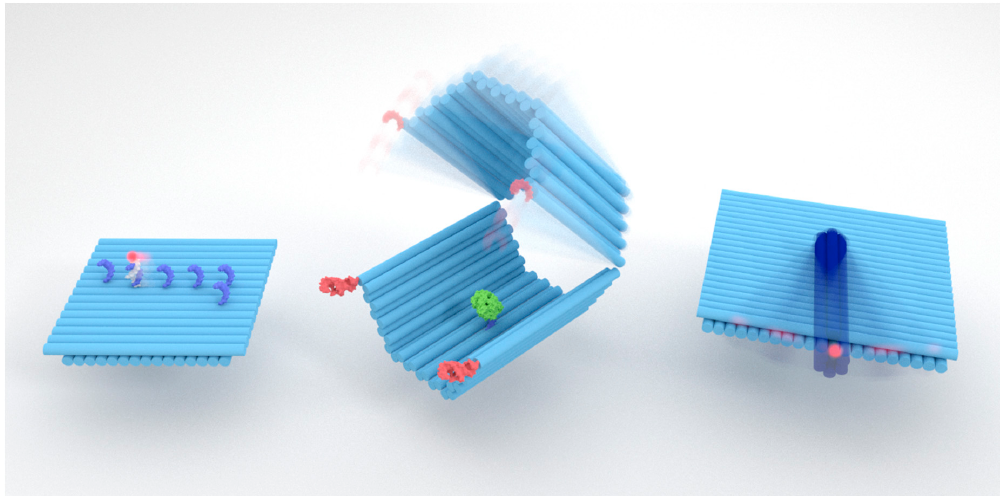
Scheme 1. Artistic rendering of selected examples of dynamic DNA origami devices: ( Left ) a cargo-sorting robot walking on a DNA origami-templated track [42]; ( Middle ) a logic-gated DNA origami “nanopill” that selectively displays the loaded cargo [12]; ( Right ) a DNA origami robotic arm that performs rotational movement under an electric field [43].